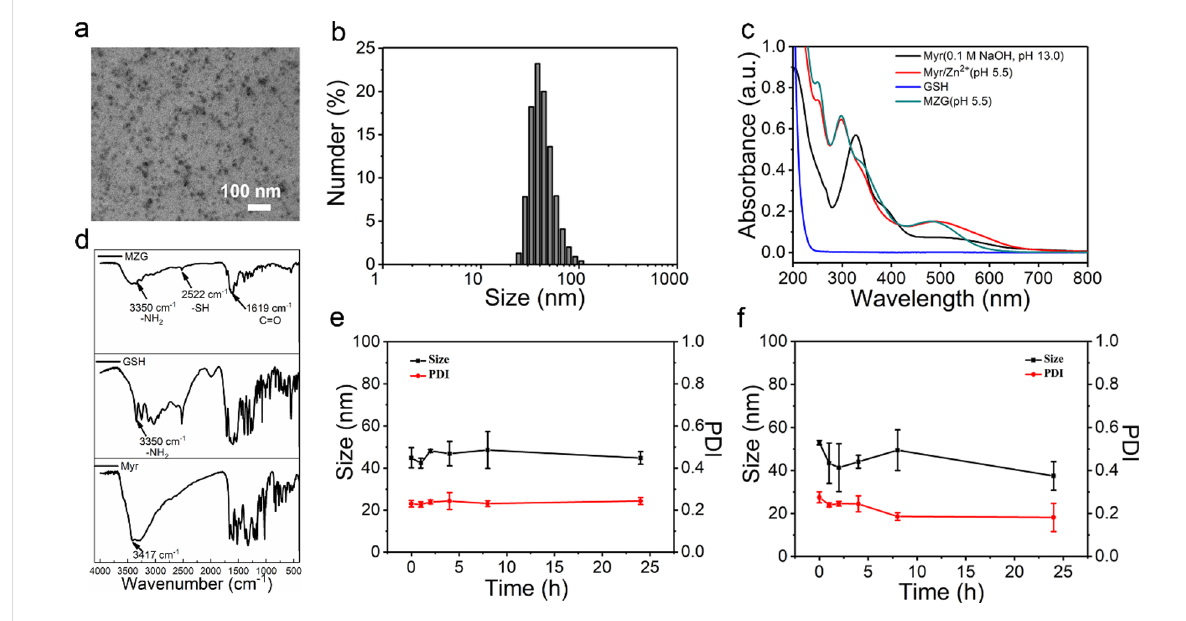
Figure 2: Physicochemical characterization of MZG nanoparticles. (a) TEM image. (b) DLS pro fi le of MZG nanoparticles. (c) UV–vis absorbance spectra of Myr dissolved in (0.1 M NaOH), Myr/Zn 2+ complex, GSH, and MZG (equivalent concentration of Myr: 20 μ g·mL − 1 ). (d) FTIR spectra of MZG, GSH, and Myr. (e) Stability evaluation of MZG nanoparticles during incubation in aqueous solution at 37 °C for 24 h. (f) Stability evaluation of MZG nanoparticles during incubation in the mixture medium of PBS containing 9% DMEM and 1% FBS (v/v) at 37 °C for 24 h (equivalent concentra- tion of Myr: 0.5 mg·mL − 1